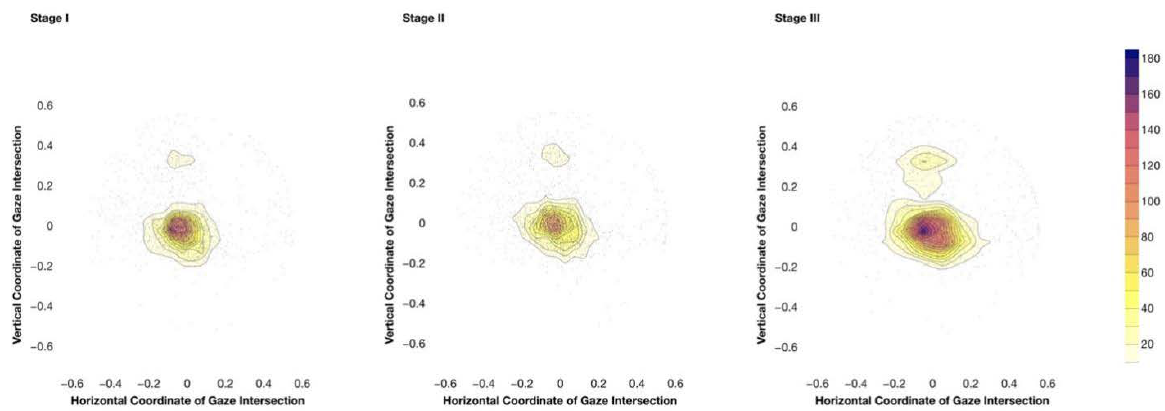
Figure 8. Eye tracking indicators under three driving stages. (Note: Figure 8a represented analysis of drivers’ horizontal gaze dispersion; Figure 8b represented analysis of drivers’ vertical gaze dis- persion; Figure 8c represented analysis of drivers’ Pupil diameters. A single asterisk (*) indicates significance at p < 0.05).